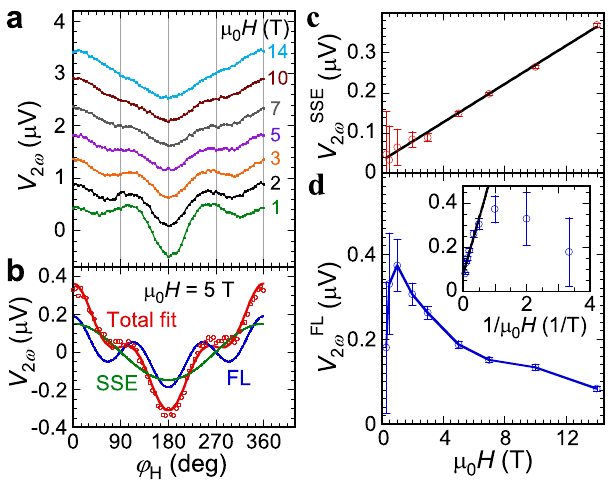
Fig. 2 Second harmonic results. a In-plane angular dependence of second harmonic Hall voltage V 2 ω at different magnetic fi elds for a Pt ( 5 nm)/ α - Fe 2 O 3 (30 nm) bilayer at 300 K. b Angular dependence of V 2 ω at, 5 T where the blue and green curves are contributions from the fi eld-like torque and spin Seebeck effect, respectively, while the red curve is the total fi t by Eq. (2). Field dependence of c spin-Seebeck effect (SSE) contribution V SSE and d fi eld-like (FL) torque contribution V FL where the inset of d shows 2 ω 2 ω exhibits a linear the corresponding 1/ H plots and linear fi tting. V SSE 2 ω dependence of fi eld. V FL shows a 1/ H dependence at μ 0 H > 1 T. Error bars 2 ω represent fi tting